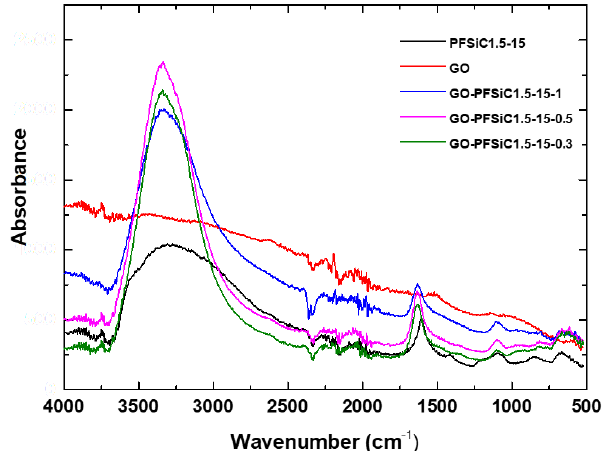
Figure 1. FTIR spectra comparing the examined materials GO, PFSiC 1.5-15 , GO-PFSiC 1.5-15-1 , GO-PFSiC 1.5-15-0.5 , and GO-PFSiC 1.5-15-0.3